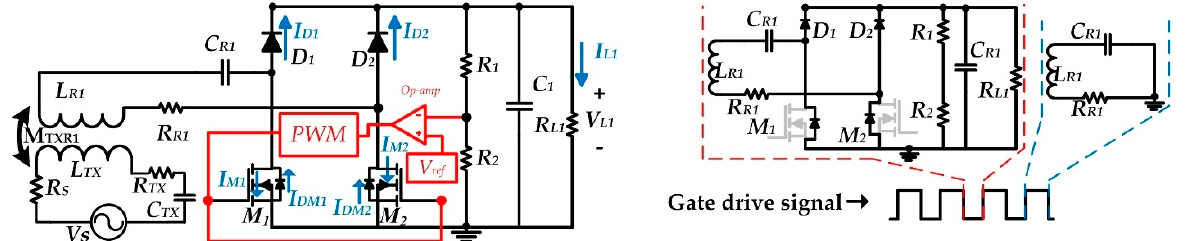
Figure 5. Circuit structure of the proposed multi-load WPT repeater system.